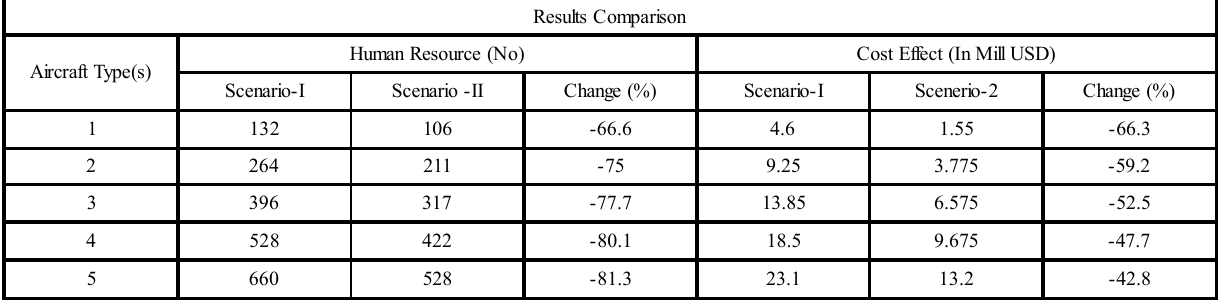
TABLE 5. COST OF PERSONNEL IN REVISED MODEL (COMPARISON)